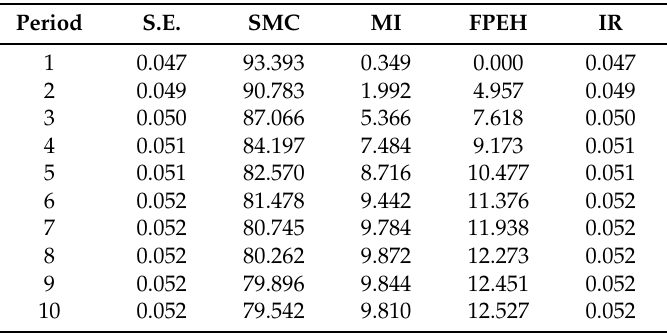
Table 8. Variance decomposition